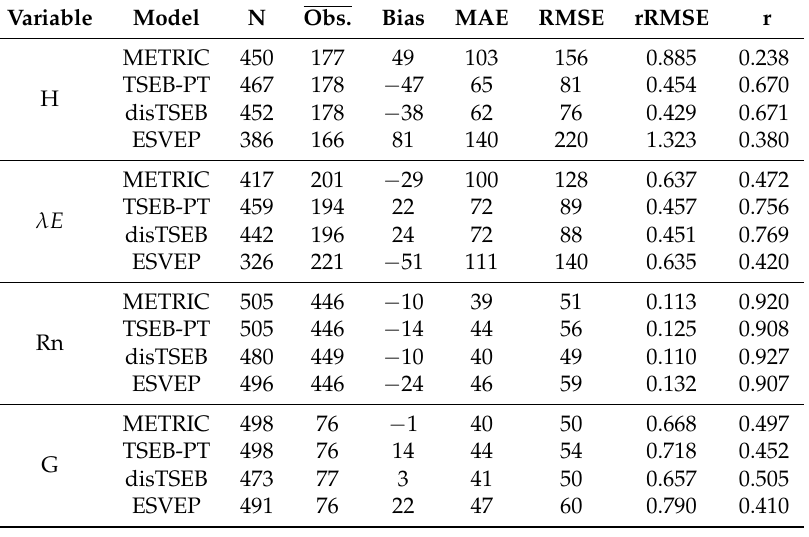
Table 3. Error metrics for METRIC, TSEB-PT, disTSEB (TSEB-PT with flux disaggregation) and ESVEP modelled fluxes using Decision Tree sharpened temperatures and closing the energy balance gap in field measurements by assigning residual energy to latent heat flux. N, number of valid cases; Obs.; mean of observed values (W m − 2 ); bias, mean difference between predicted and observed (W m − 2 ); RMSE (–); r, Pearson correlation coefficient (–).